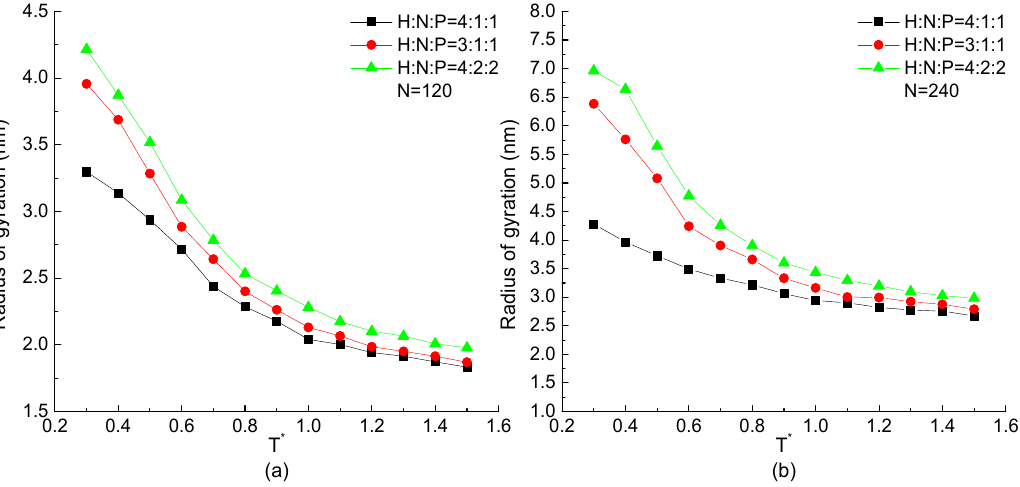
Figure 5. The radius of gyration versus reduced temperature T * of H4N1P1, H3N1P1, and H4N2P2 with chain length of ( a ) N = 120, ( b ) N = 240 .